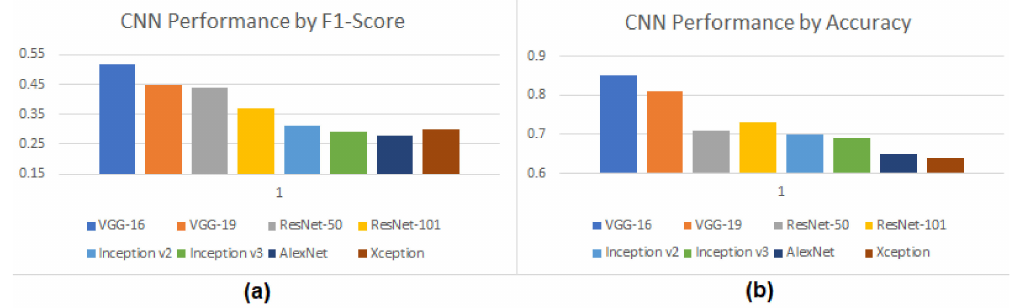
Figure 7. Results of CNN Image Classification testing by ( a ) F1-Score and ( b ) Accuracy, 70/30